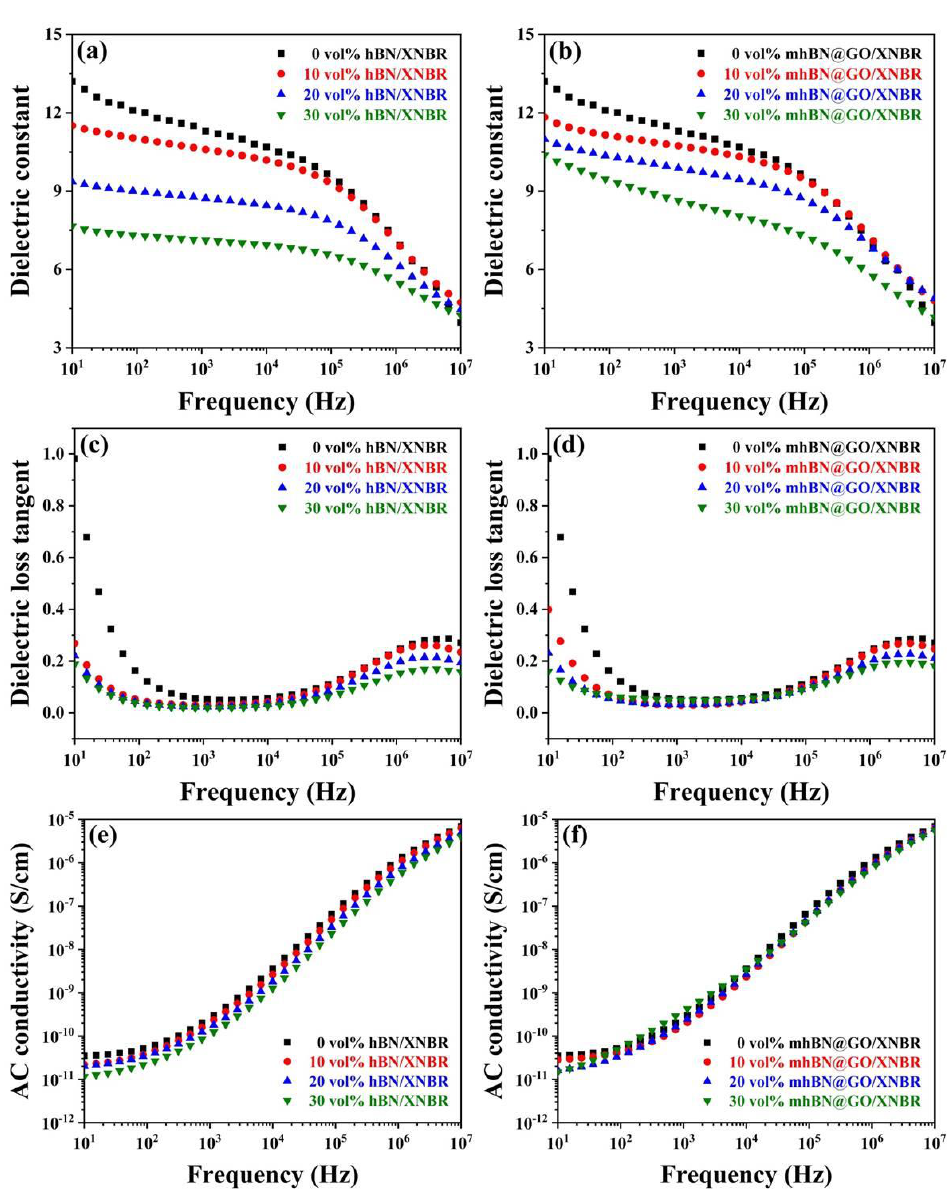
Figure 7. ( a , b ) Dielectric constant, ( c , d ) dielectric loss tangent, and ( e , f ) AC conductivity as functions of frequency for hBN/XNBR and mhBN@GO/XNBR composites,